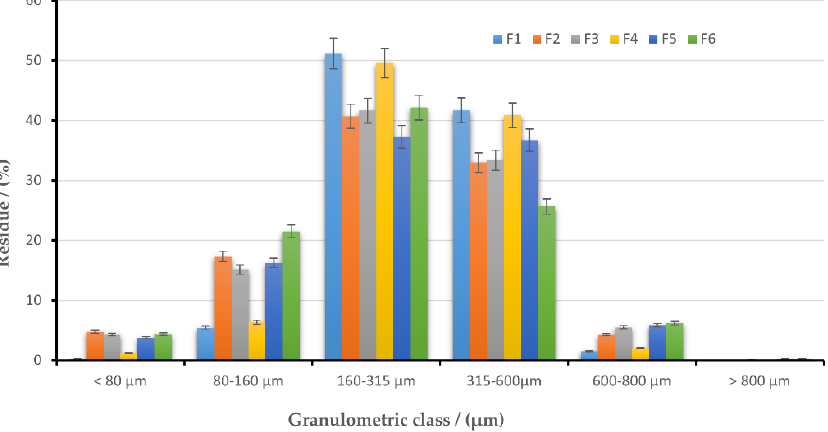
Figure 9. Granulometric analysis of the direct compression blends (F1 is AML-HP- β -CD with silicified microcrystalline cellulose, sodium starch glycolate, and magnesium stearate; F2 is AML-HP- β -CD with F-MELT, sodium starch glycolate, and magnesium stearate; F3 is AML-HP- β -CD with Ludiflash, sodium starch glycolate, and magnesium stearate; F4 is AML-Me- β -CD with silicified microcrystalline cellulose, sodium starch glycolate, and magnesium stearate; F5 is AML-Me- β -CD with F-MELT, sodium starch glycolate, and magnesium stearate; F6 is AML-Me- β -CD with Ludiflash, sodium starch glycolate, and magnesium stearate).